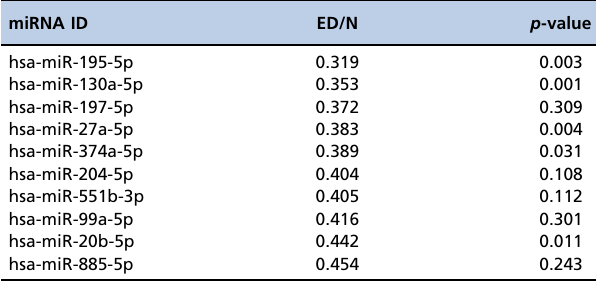
Table S4 - Ten significant downregulated miRNAs in patients with EH and T2DM.